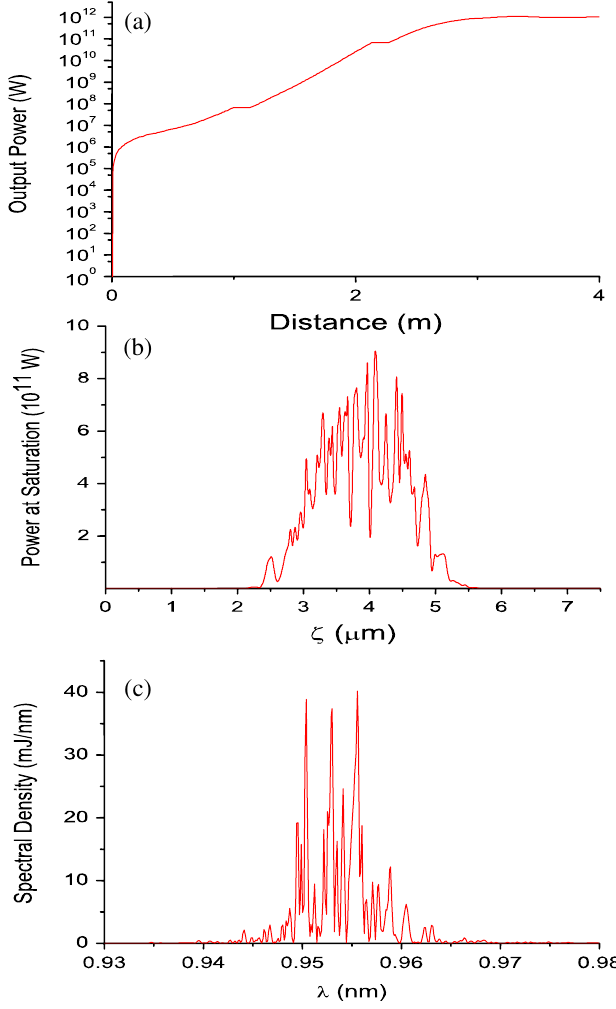
FIG. 11. (Color) GENESIS results for the ( T 3 ) SASE FEL. (a) Saturation occurs in 3 m. (b) The soft x-ray energy is distributed fairly uniformly over the entire length of the pulse. (c) The spectral makeup if the beam is noisy, expected from such a large emittance